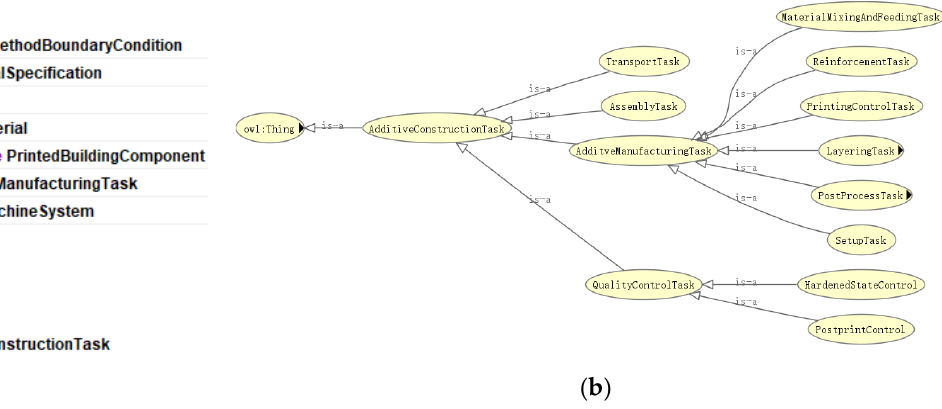
Figure 8. ( a ) Important entities related to AM methods; ( b ) Taxonomy of tasks defined by additive manufacturing plan. manufacturing